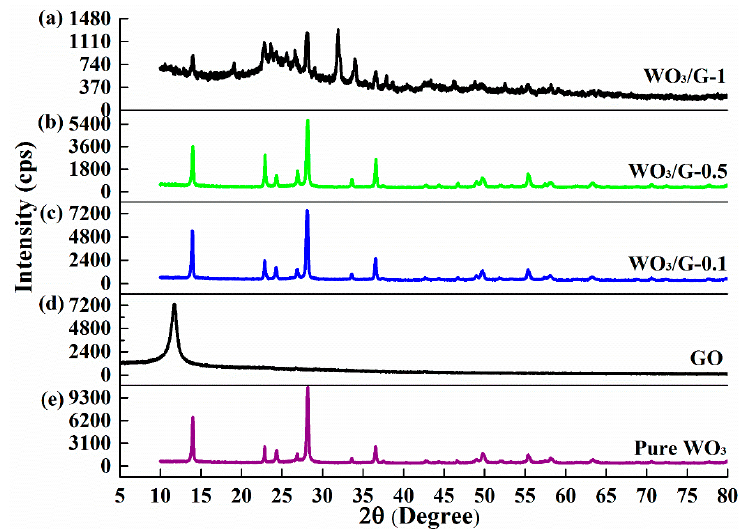
Figure 1. XRD patterns of pure WO3 and WO3/GR nanocomposites with different contents of GO. ( a ) WO3/G-1; ( b ) WO3/G-0.5; ( c ) WO3/G-0.1; ( d ) GO; ( e ) Pure WO3.